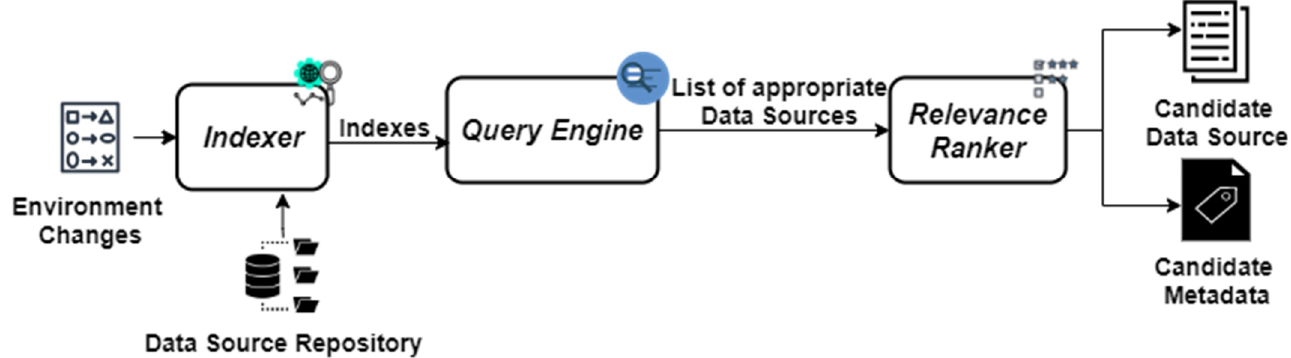
Figure 2. Data source search engine.